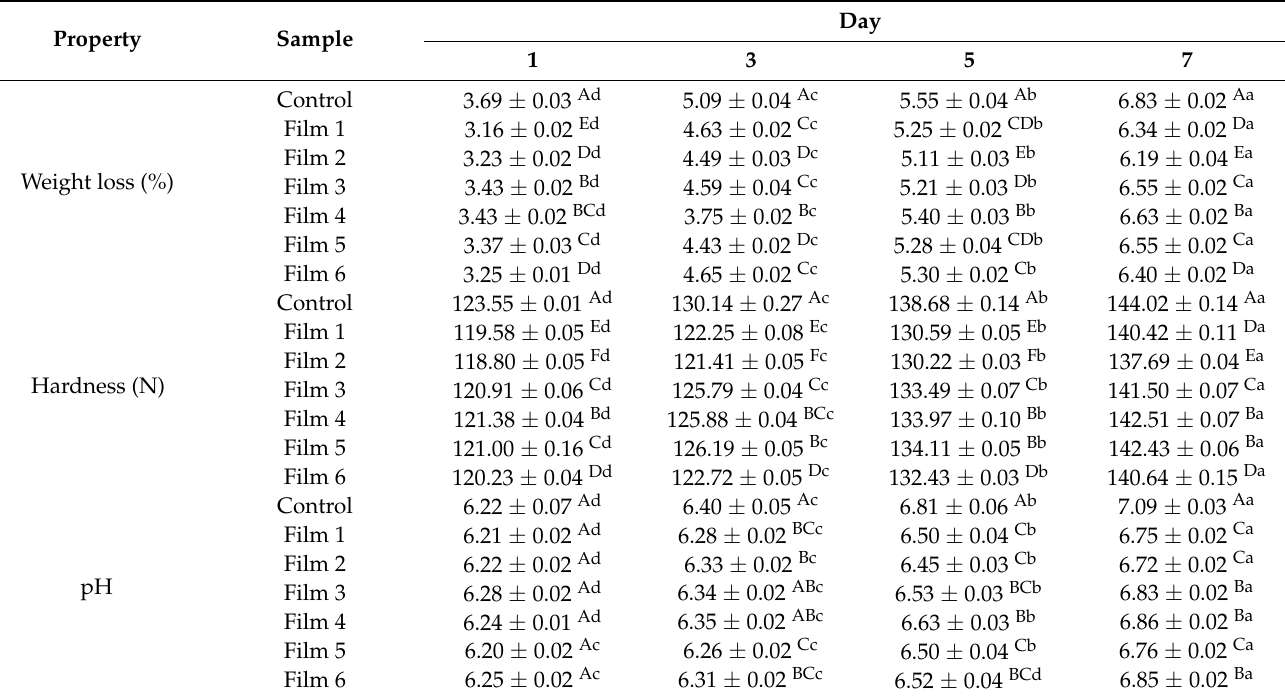
Control: polypropylene (PP) microwavable container. Capital letters of A – E represent significant differences ( p < 0.05) amongst samples for each day for each property. Small letters of a – d represent significant differences ( p < 0.05) amongst storage days for each sample for each